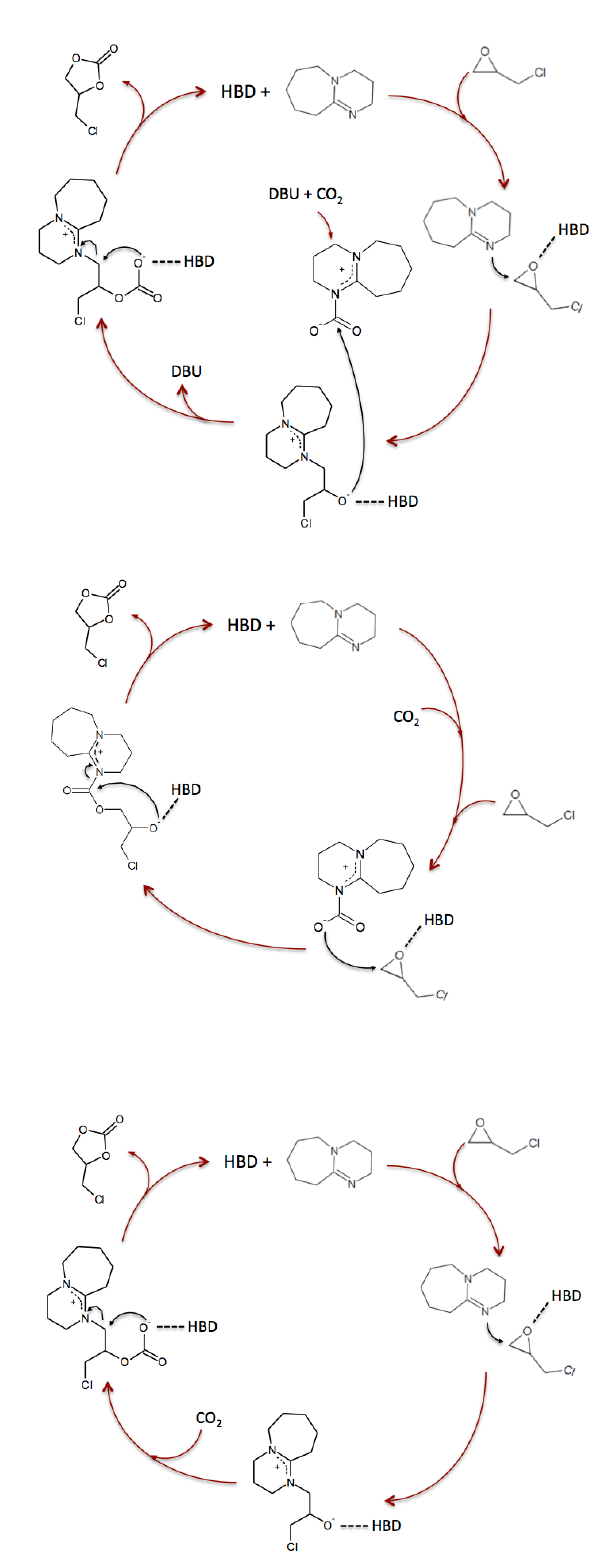
Figure 4. Plausible mechanisms of the chemical fixation of CO 2 into epichlorohydrin (EP) catalyzed by DBU in the presence of a hydrogen bond donor (HBD), according to those proposed in previous works ( A , B ) and according to the NMR results obtained in this work ( C